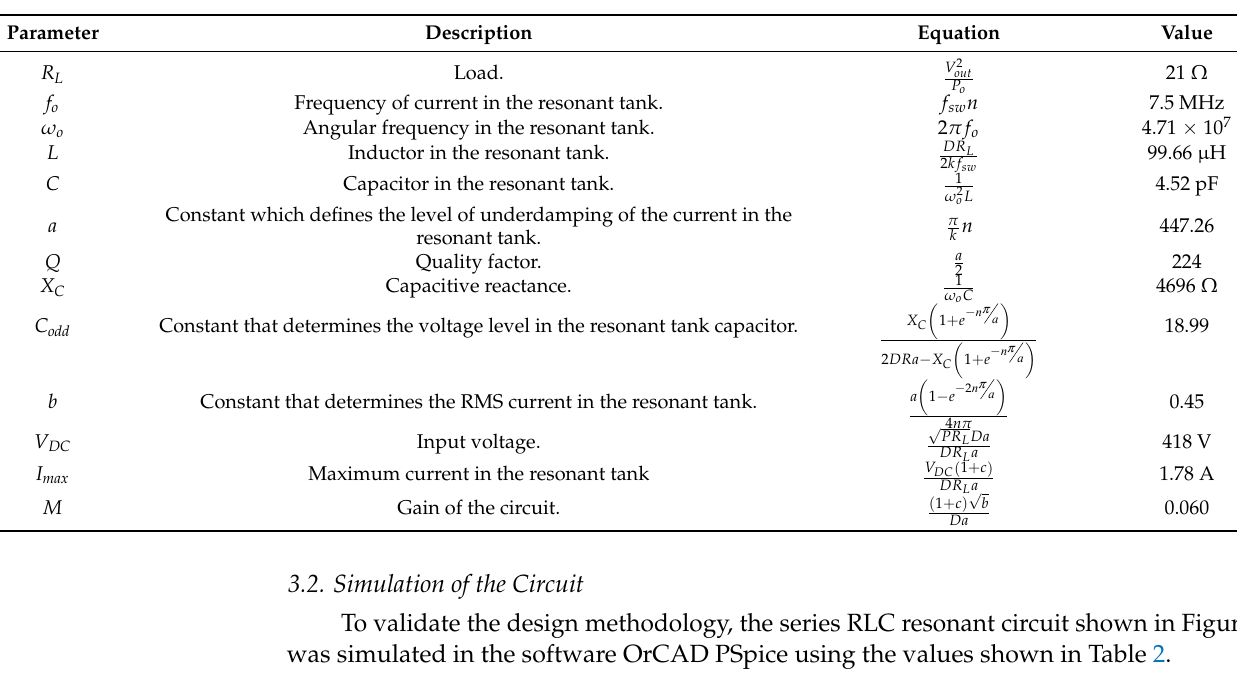
Table 2. Design methodology.